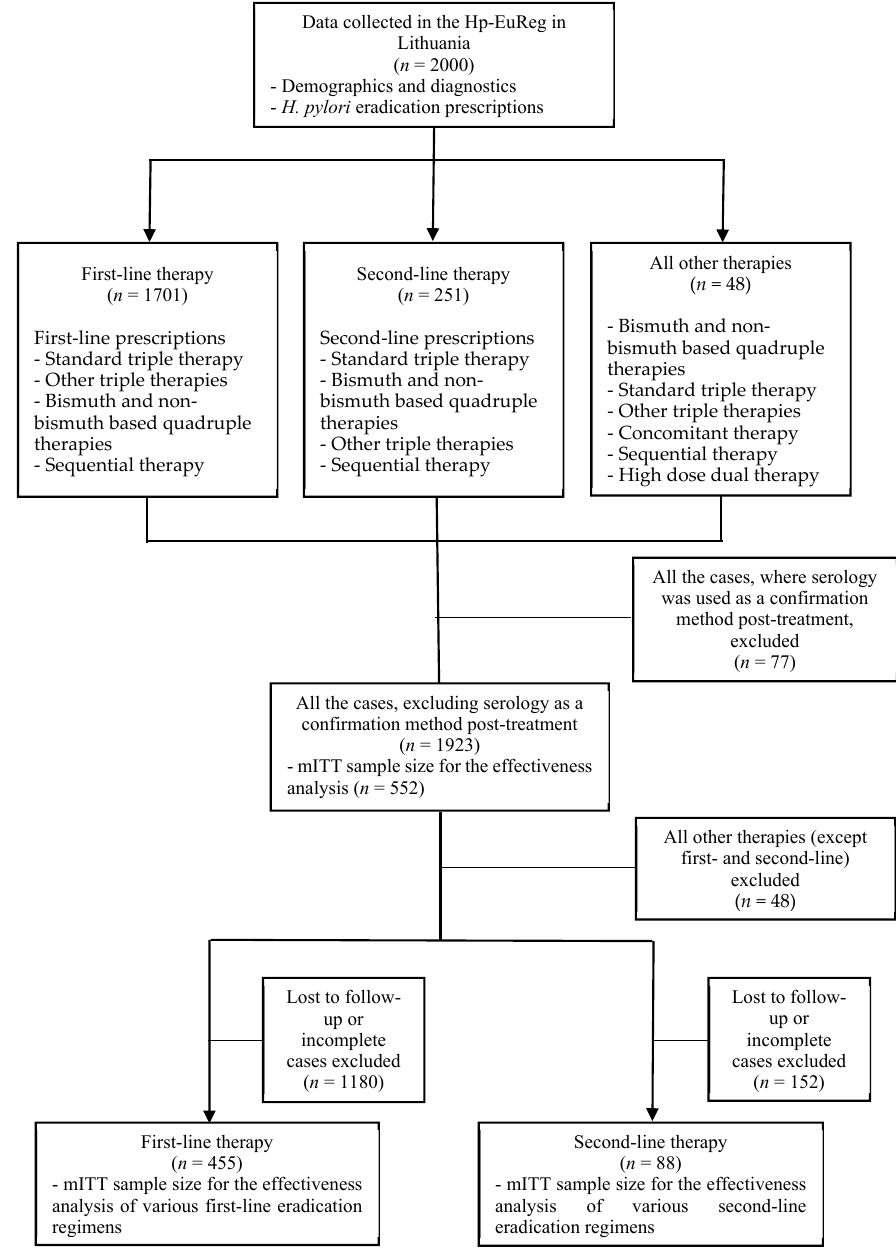
Figure 1. Study flow chart. mITT—modified Intention-to-treat. The most prescribed H. pylori eradication scheme was standard triple therapy, which consists of a PPI, clarithromycin and amoxicillin—in 79% of the cases. The second most prescribed regimen was a triple therapy, consisting of a PPI, amoxicillin and levofloxa- cin—it was prescribed in 8% of the overall cases and was usually used as the main second- line prescription. Bismuth and non-bismuth-based quadruple therapies were prescribed